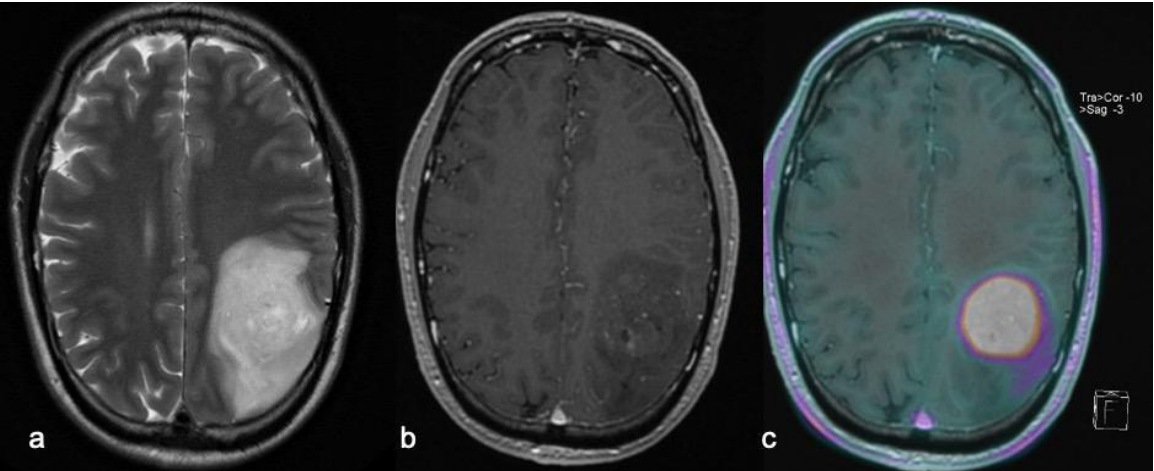
Figure 5. Left parietal H3G34 glioma with little perilesional edema appearance on T2w fast spin echo imaging ( a ) and focal slight contrast enhancement after Gd-based contrast media injection on T1w sequences ( b ), showing vivid radiotracer uptake upon FET-PET imaging ( c ).